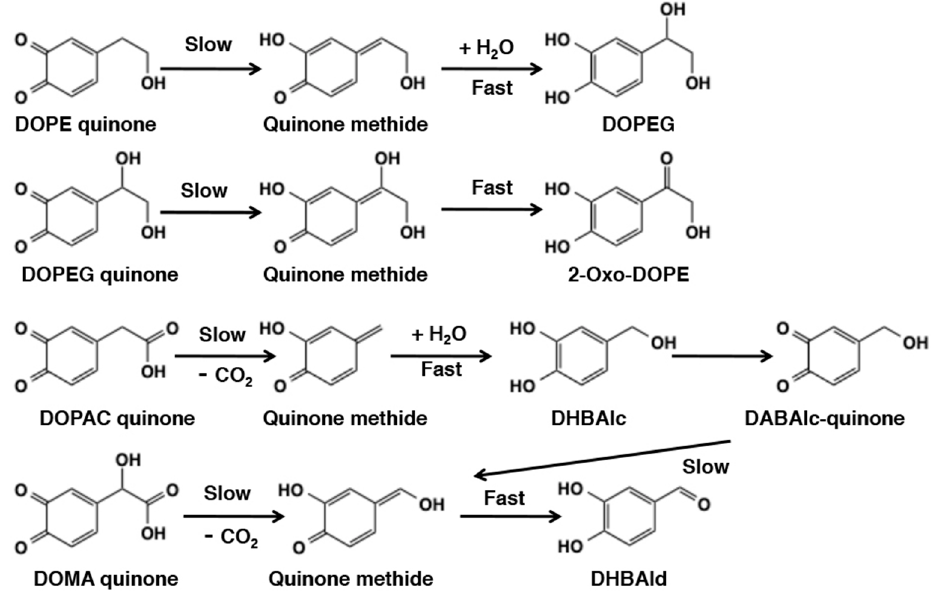
Figure 19. Reaction of o -quinone products from catecholamine metabolites 3,4-Dihydroxyphenylethanol (DOPE), 3,4-dihydroxyphenylethyleneglycol (DOPEG), 3,4-dihydroxyphenylacetic acid (DOPAC), and 3,4-dihydroxymandelic acid (DOMA) [94]. Tyrosinase-catalyzed oxidation of the catechols was terminated by the addition of ascorbic acid. Note that the formation of quinone methides proceeds slowly, which is quickly followed by the addition of water molecule or the formation of carbonyl group.